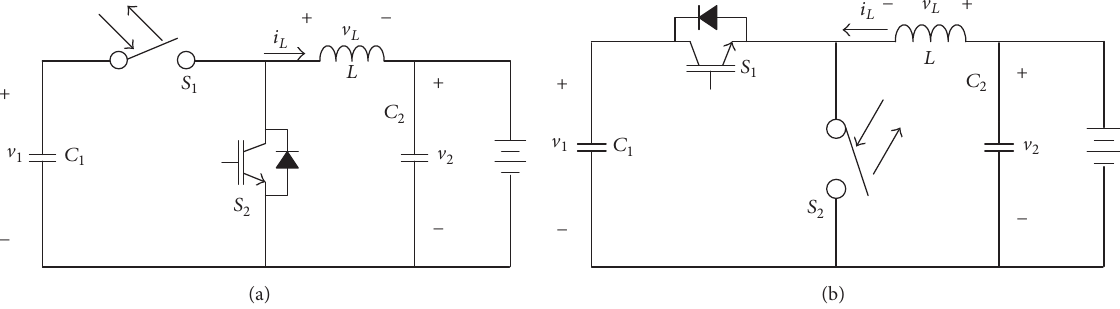
Figure 4: Battery charger operational circuit diagram. (a) Buck converter for charging mode; (b) boost converter for discharging